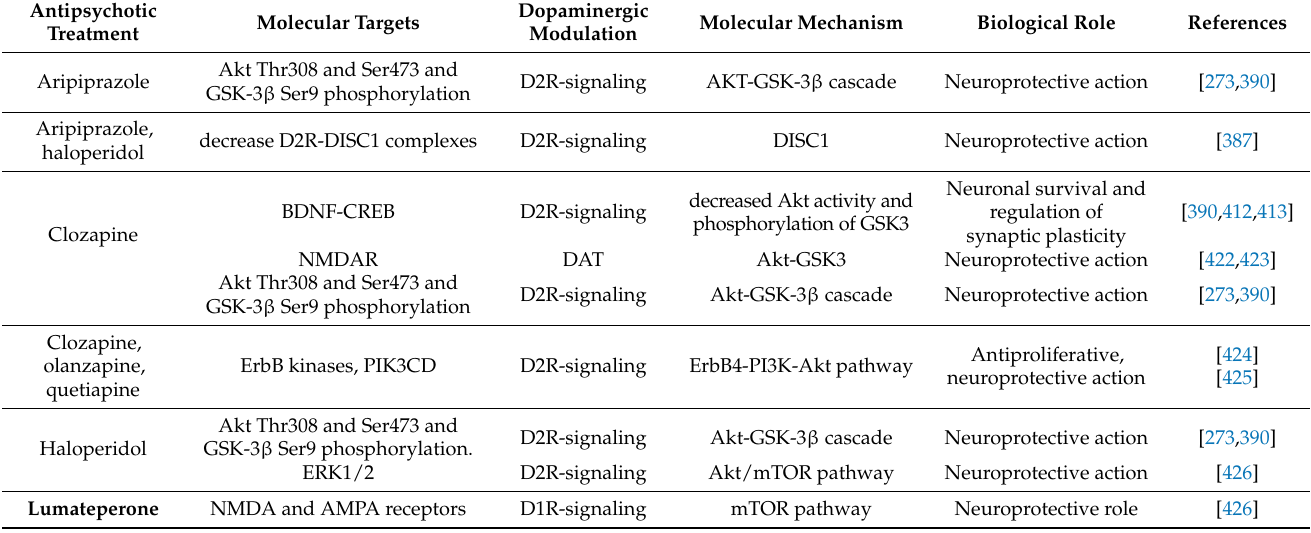
Table 2. Intracellular mechanism of antipsychotic drugs and dopaminergic correlation. Abbreviations: Akt = protein-kinase B; AMPA = α -amino-3-hydroxy-5-methyl-4-isoxazolepropionic acid; BDNF = brain-derived neurotrophic factor; CREB = cAMP response element-binding protein; D2R = dopamine D2 receptor; DISC1 = disrupted in schizophrenia 1; ErbB = erythroblastic leukemia viral oncogene homologue; ERK = extracellular signal-regulated kinase; GSK3 = glycogen synthase kinase 3; mTOR = mammalian target of rapamycin; NMDA = N-methyl-D-aspartate; DAT = Dopamine